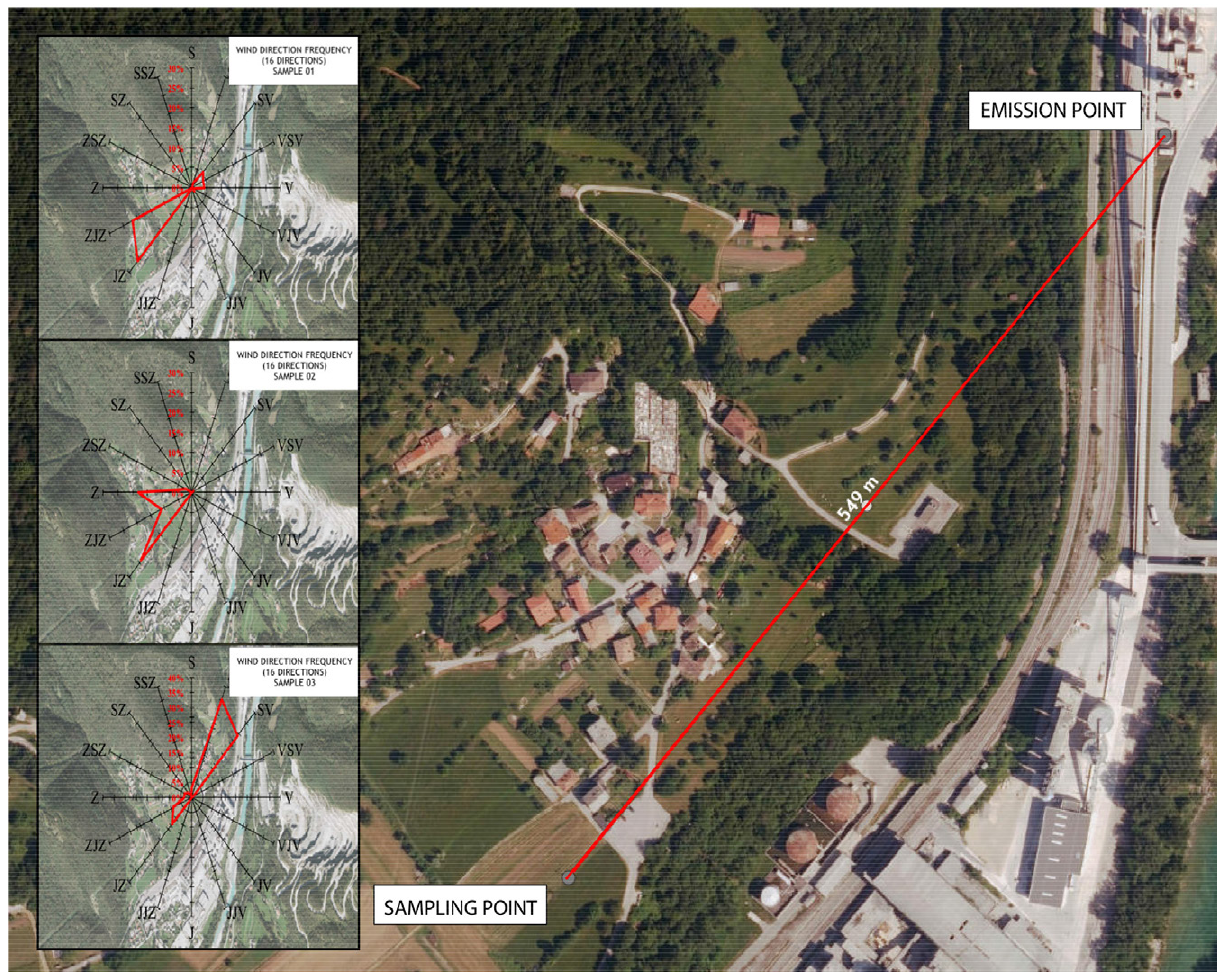
Figure 1. Position of the sampling point, the direction and distance to the emission source. Left: wind roses diagram for sample 01, 02 and 03 from 6. July to 9. July 2015.